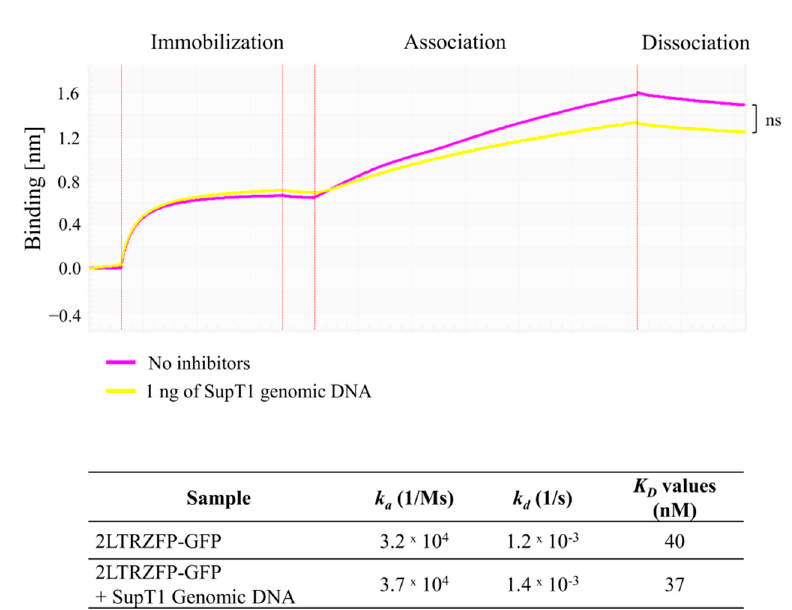
Figure 5. The off-target effects of 2LTRZFP-GFP towards SupT1 genomic DNA. The off-target effect of 2LTRZFP-GFP was determined by letting 2LTRZFP-GFP bind to SupT1 genomic DNA in the tube. The representative kinetic sensorgrams from triplicate experiments demonstrated the kinetic binding of 2LTRZFP-GFP in the condition with or without SupT1 genomic DNA. Statistical significance was evaluated by Student’s t -test; ns, not significant.